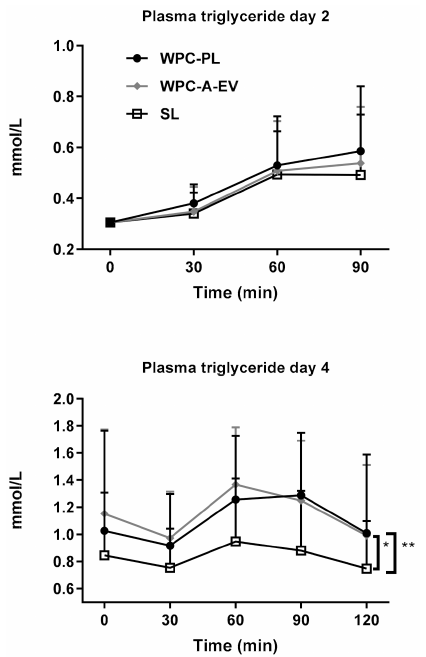
Figure 5. Triglyceride levels in plasma at day two (WPC-A-EV n = 16, WPC-PL n = 16, SL n = 17) and four (WPC-A-EV n = 15, WPC-PL n = 14, SL n = 17), baseline sample and 30, 60, 90 and 120 min after